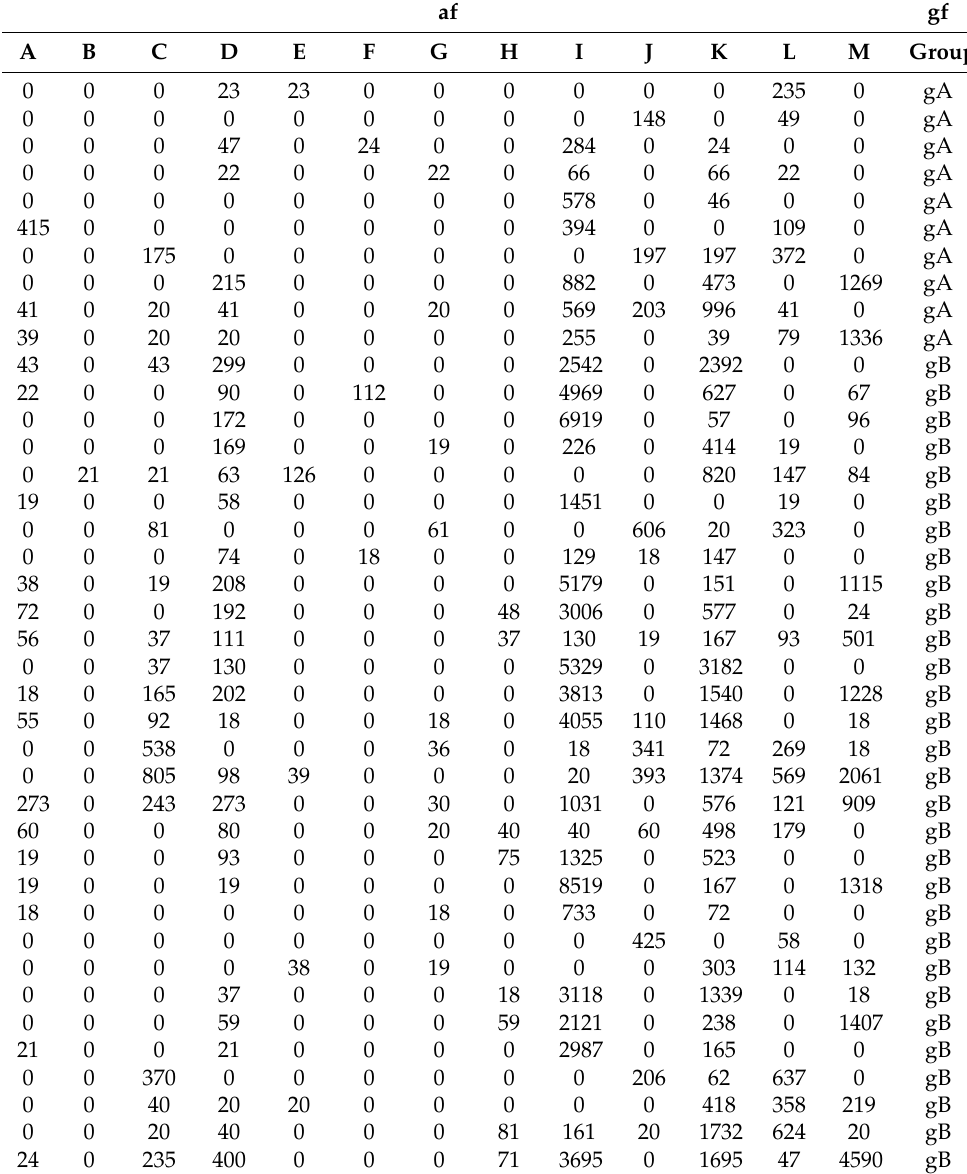
Table A1. Abundance data by species and sample for each Group of samples used in the example. The columns under af show the data included in the abundance file, whereas the column under gf shows the data included in the groups file. A, B, C, D, E, F, G, H, I, J, K, L and M are the names of the